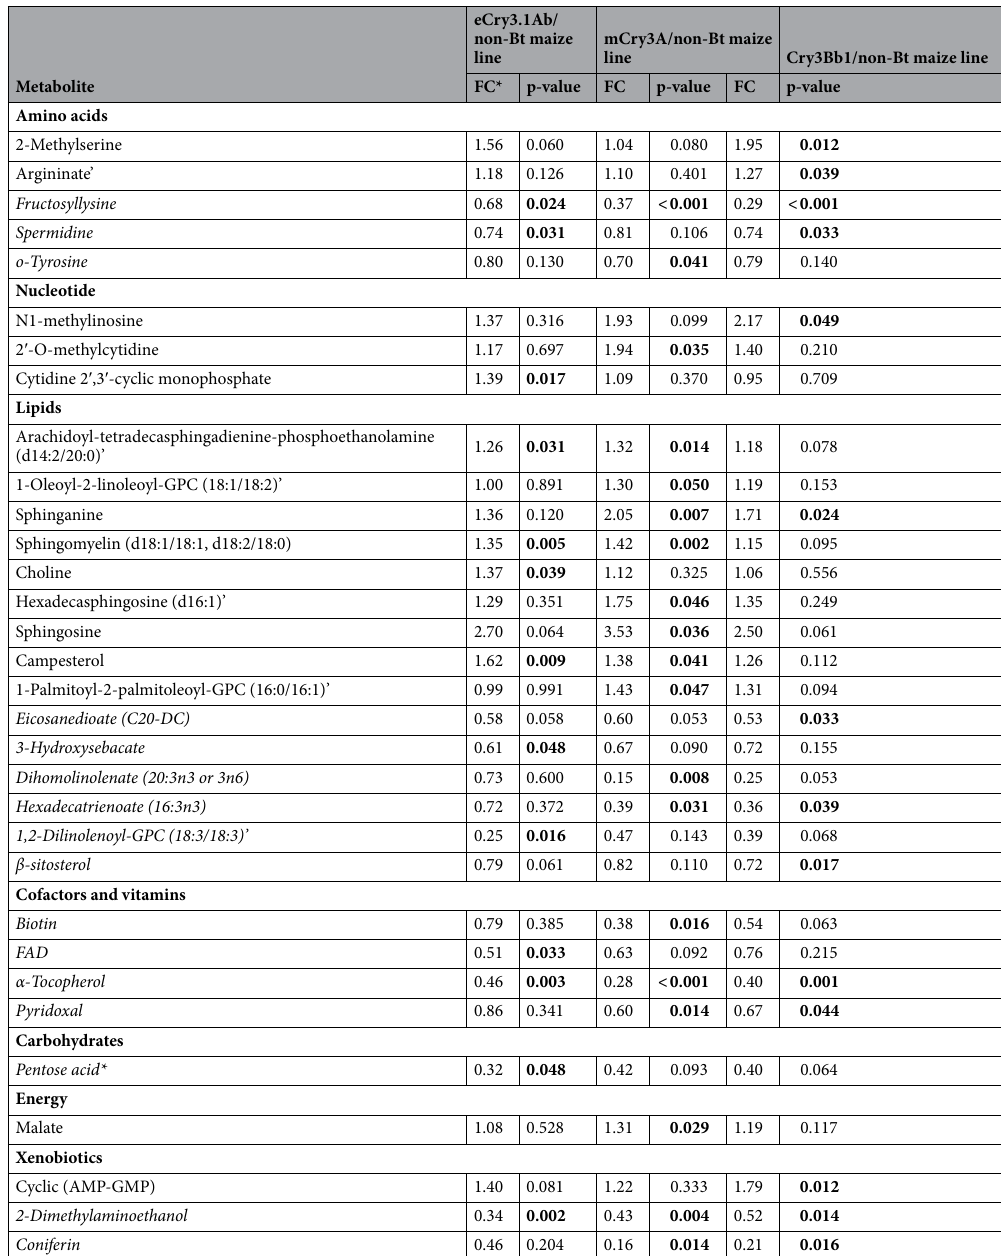
Table 3. Metabolites with significantly altered expression in susceptible larvae fed on Bt-expressing maize lines (eCry3.1Ab, mCry3A, or Cry3Bb1) compared to those fed on a non-Bt maize control line. *Data are expressed as fold change (FC) and corresponding p-value. Fold changes were calculated by dividing relative concentrations of metabolites in the susceptible larvae fed on Bt maize lines expressing each of three available Cry3 proteins by that in those fed on the non-Bt maize line. Metabolites in italic represent higher levels in the susceptible larvae fed on the non-Bt maize isoline compared to Bt maize. All the other metabolites accumulated in larvae when reared on Bt maize compared with the non-Bt maize line. Metabolite identification was confirmed with authentic standards, expected for the metabolites followed with (’) that were annotated based on their available identities (e.g., m/z , mass spectra). Significant p values (< 0.05) were in